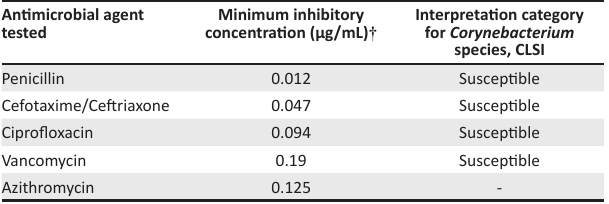
TABLE 1: Antimicrobial susceptibility testing results of the Corynebacterium pseudodiphtheriticum strain isolated on nasal swab from a 14-month-old infant presenting with exudative pharyngitis.